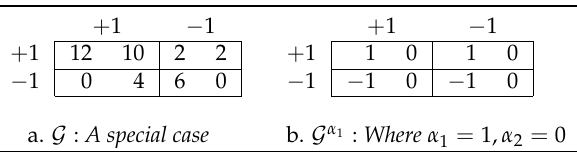
Table 4. Decomposing a game.